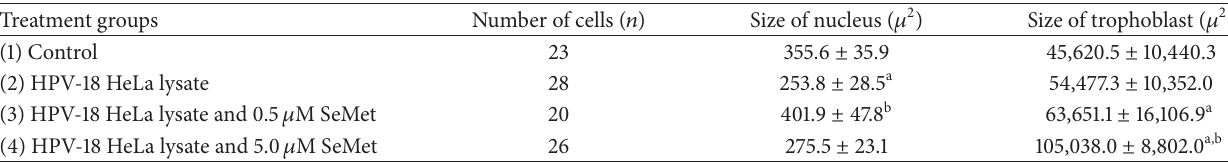
Table 1: Comparison of the area (mean ± S.E.M.) of each trophoblast nucleus or each trophoblast cell size after 24-hour exposure (at 37 ∘ C, in air) to either (1) control medium with heat-inactivated HPV-18 HeLa lysate, (2) HPV-18 HeLa lysate, (3) HPV-18 HeLa lysate 5% CO 2 and 0.5 𝜇 M selenomethionine (SeMet), or (4) HPV-18 HeLa lysate and 5.0 𝜇 M SeMet. The ICM cells were not analyzed due to limitations in stained compacted cells.